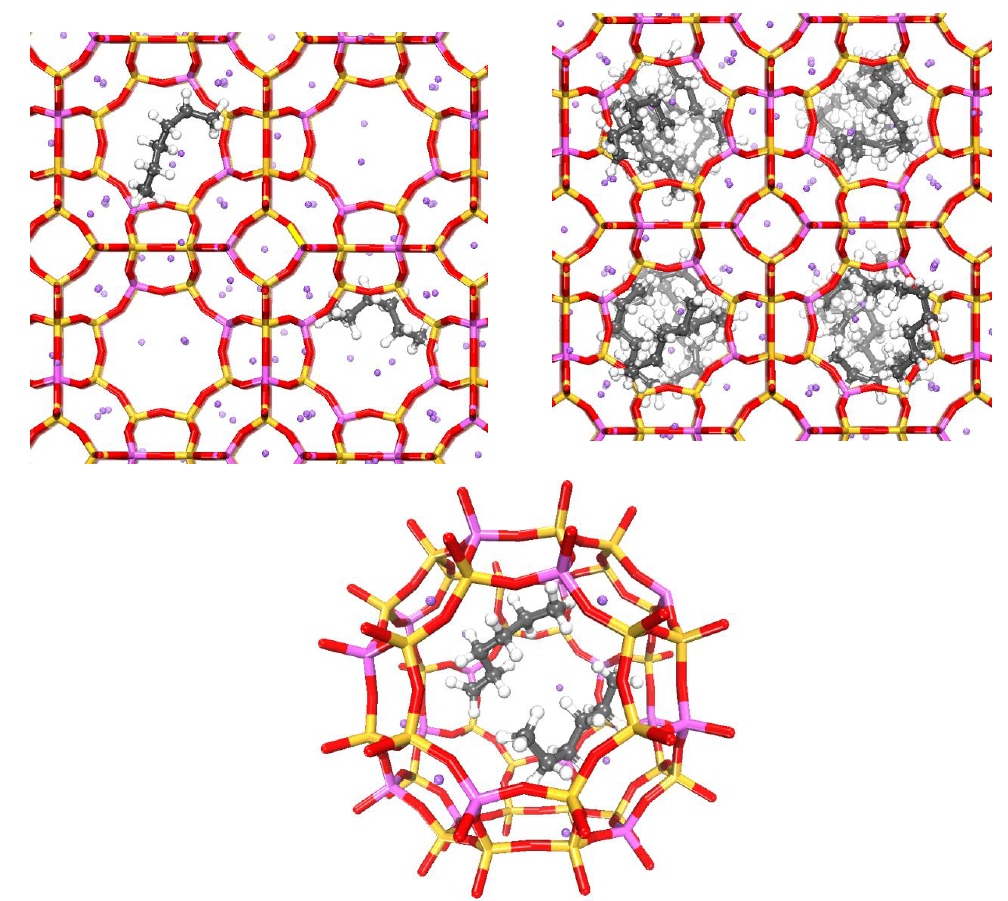
Figure 7. CB–GCMC simulation extracted snapshots illustrating the n -hexane molecules’ confinement within the ZK-4 zeolite porosity, respectively at low (on the left) and high (on the right) coverage at 25 °C. The bottom picture shows an arrangement of two n -hexane molecules adsorbed within the α- cage.